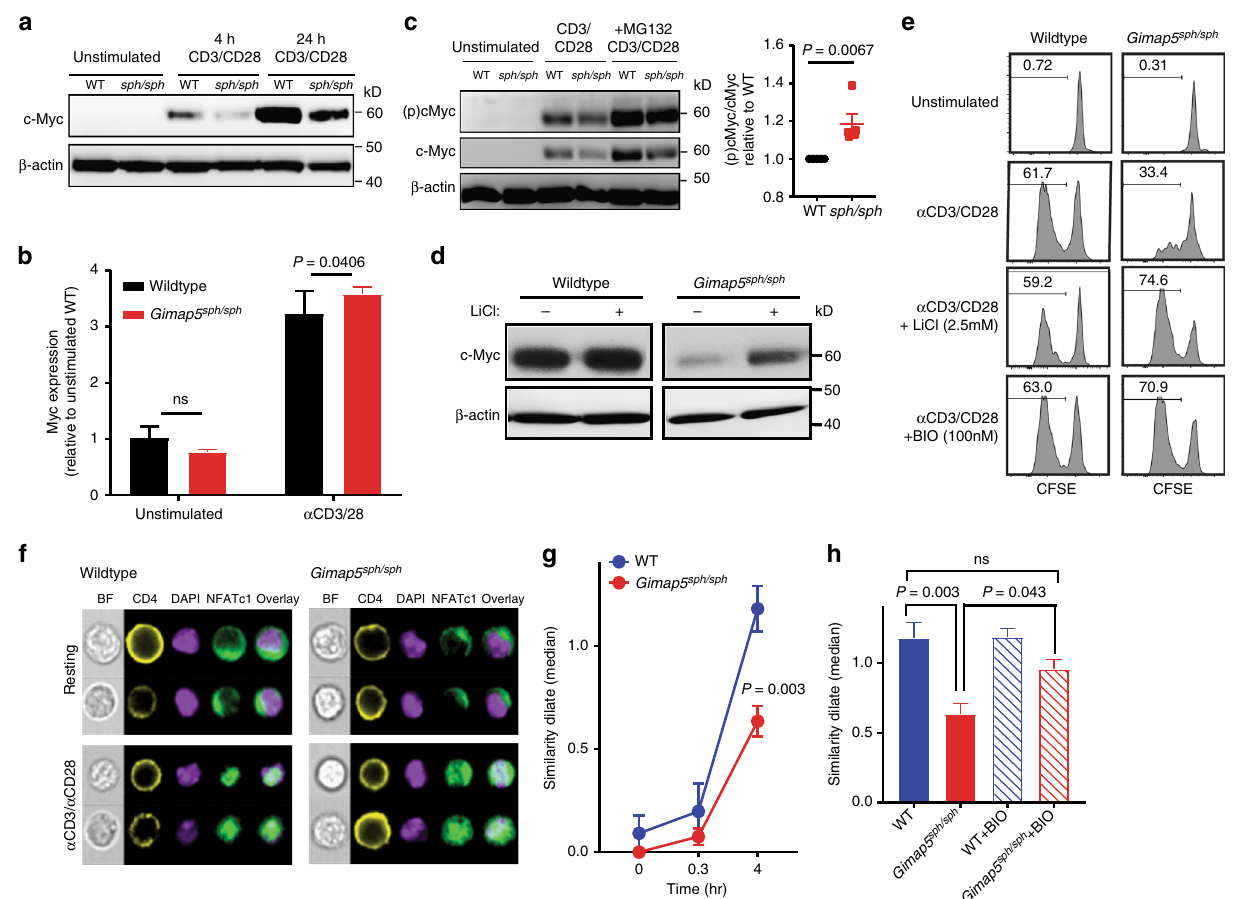
Fig. 2 Impaired CD4 + T cell proliferation is associated with increased GSK3 activity. a Immunoblot analysis of c-Myc expression in total lysates of CD4 + T cells from WT and Gimap5 sph/sph mice stimulated with α CD3/ α CD28 or during resting conditions. b Myc mRNA levels in resting and α CD3/ α CD28- activated (24 h) CD4 + T cells. Data represent mean expression ± SD relative to unstimulated WT cells ( n = 6). c Phosphorylation c-Myc (T58) after 24 h of α CD3/ α CD28 stimulation. Proteasomal inhibitor MG132 was added after 20 h of stimulation. Ratio of p-c-Myc (T58) to total c-Myc in MG132-treated Gimap5 sph/sph CD4 + T cells relative to WT ( n = 5). d C-Myc expression in WT and Gimap5 sph/sph CD4 + T cells stimulated for 24 h with α CD3/ α CD28 ± 2.5 mM LiCl. e Proliferation of WT and Gimap5 sph/sph CD4 + T cells in the presence/absence of α CD3/ α CD28 and/or GSK3 inhibitors BIO (100 nM) or LiCl (2.5 mM) as measured by CFSE dilution after 3 days. Experiments were repeated fi ve times and representative plots from a single experiment are shown. f Representative images of NFATc1 localization in resting and α CD3/ α CD28-activated WT and Gimap5 sph/sph CD4 + T cells. Bright detail similarity quanti fi cation of NFATc1 nuclear localization upon stimulation ( g ) and in the presence/absence of BIO ( h ) for 4 h ( n = 6). Graphs depict mean values ± SEM. ImageStream data represent average values of > 500 CD4 + T cells per sample; all experiments were performed at least three times. Statistical signi fi cance is determined by Student ’ s two-tailed test. BF bright fi